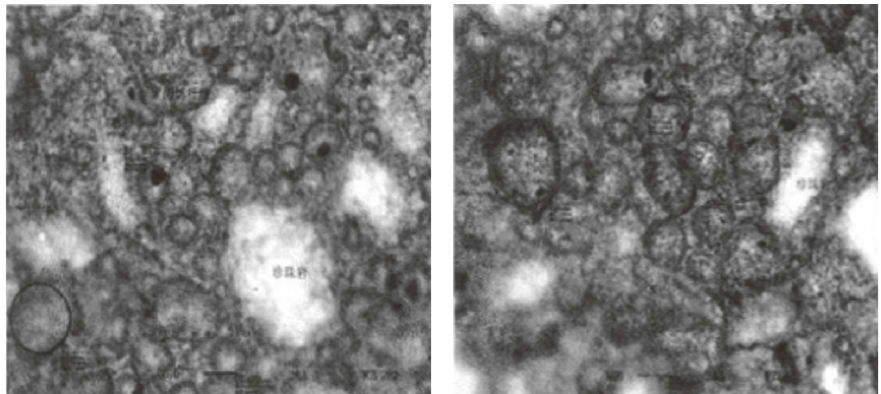
Figure 9: Pore structure of the filling material magnified by 60